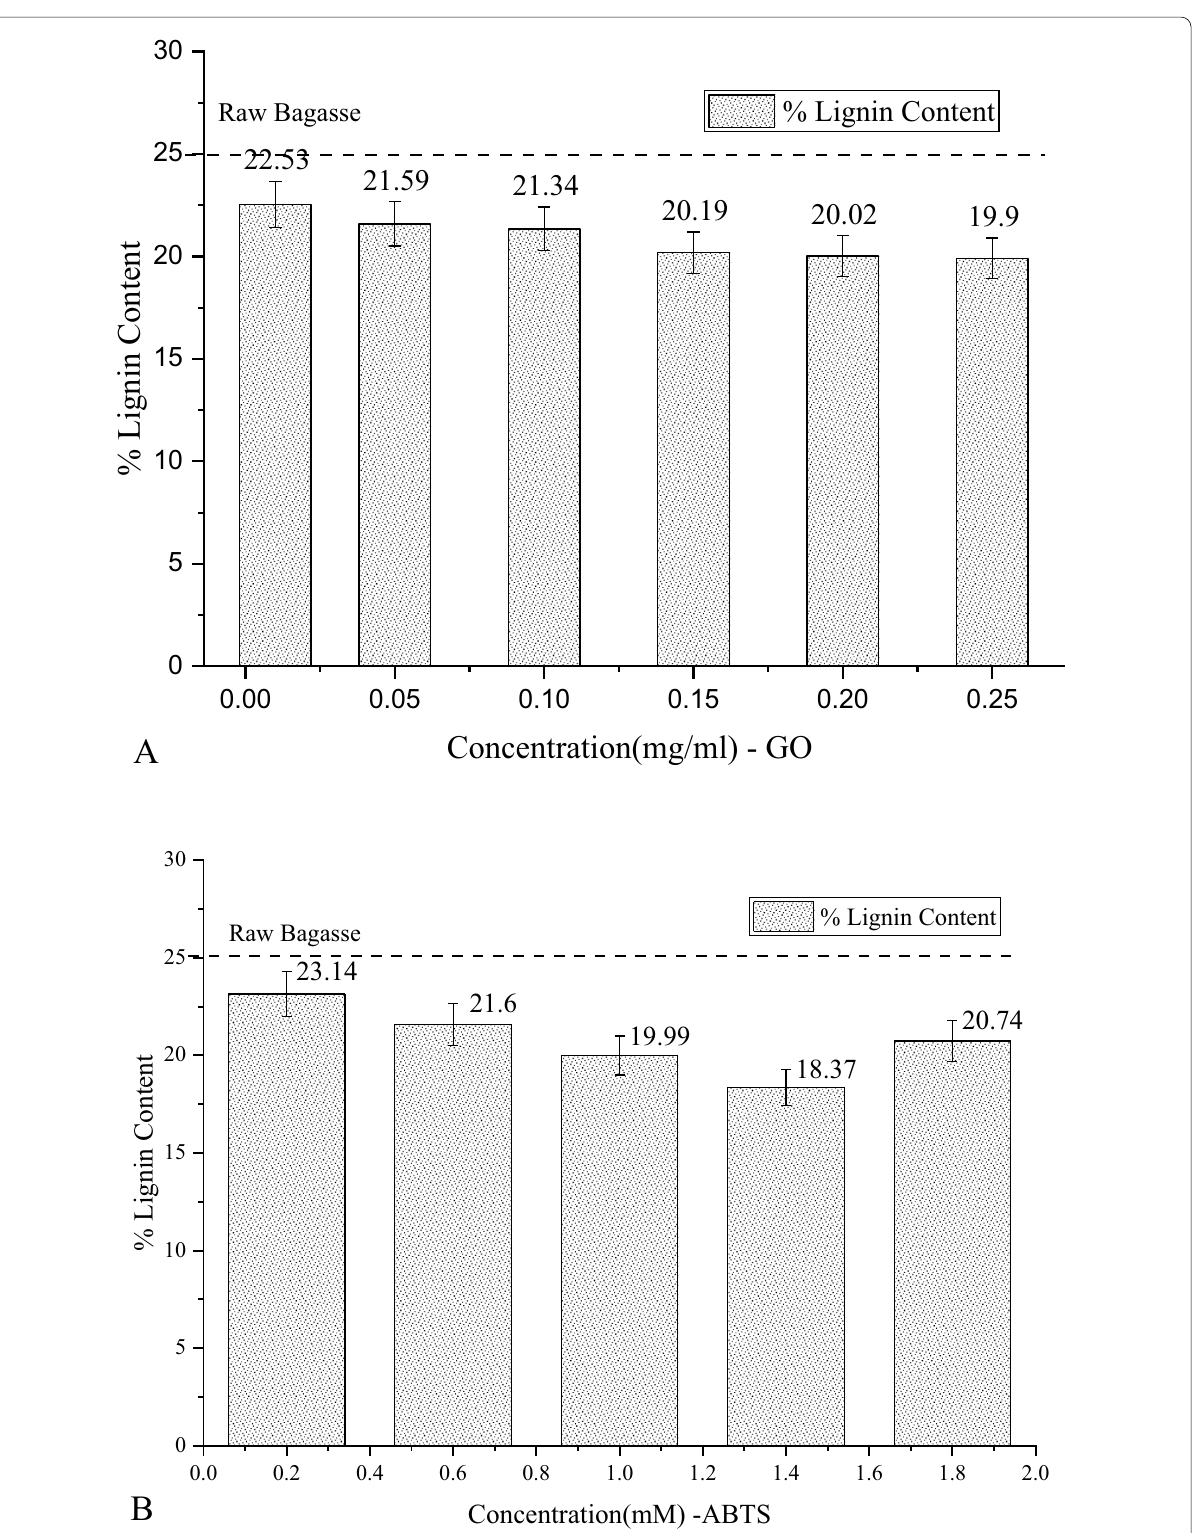
Fig. 2 A Percentage of lignin present in sugarcane bagasse at different concentrations of glucose oxidase (mg ml − 1 ). B Percentage of lignin present in sugarcane bagasse at different concentrations of ABTS